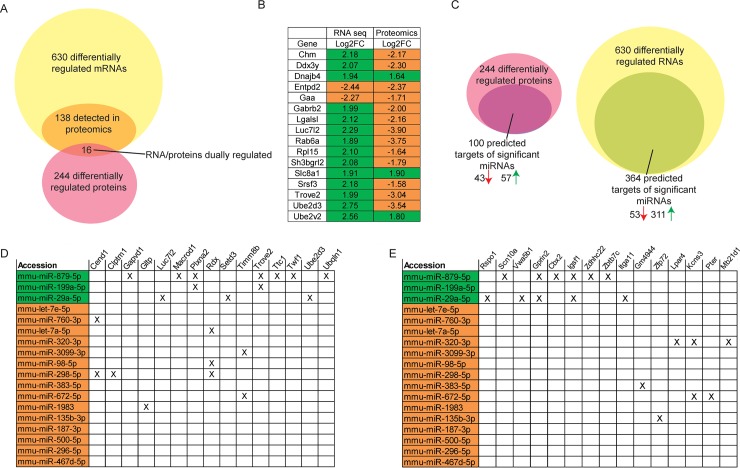
Integration of RNA-seq, smRNA seq and proteomics datasets.(A) Venn diagram displays the overlap of differentially expressed genes at the RNA and protein levels. 16 proteins were regulated at both levels and their log2 fold change (Log2FC) values for each measure are depicted in (B). Upregulated changed are highlighted in green and downregulated changes are highlighted in orange. (C) Integration of the datasets identified putative miRNA targets that are regulated in the opposite direction from significantly changed miRNAs in both the proteomics and RNA-seq datasets. (D-E) Matrices depict the differentially expressed miRNAs that also target the top 15 most regulated genes at the RNA (D) or protein level (E) in an opposing fashion. Upregulated miRNAs are highlighted in green and downregulated in orange.